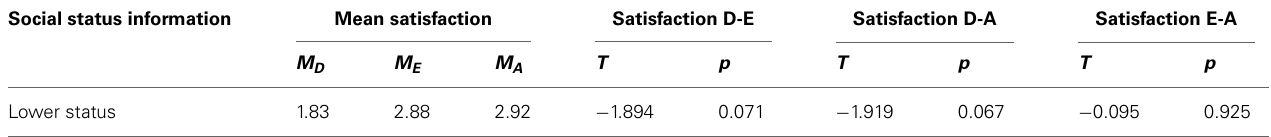
Table A2 | Mean satisfaction ratings and p -values in low status group (i.e., Subjects face higher status only). Social status